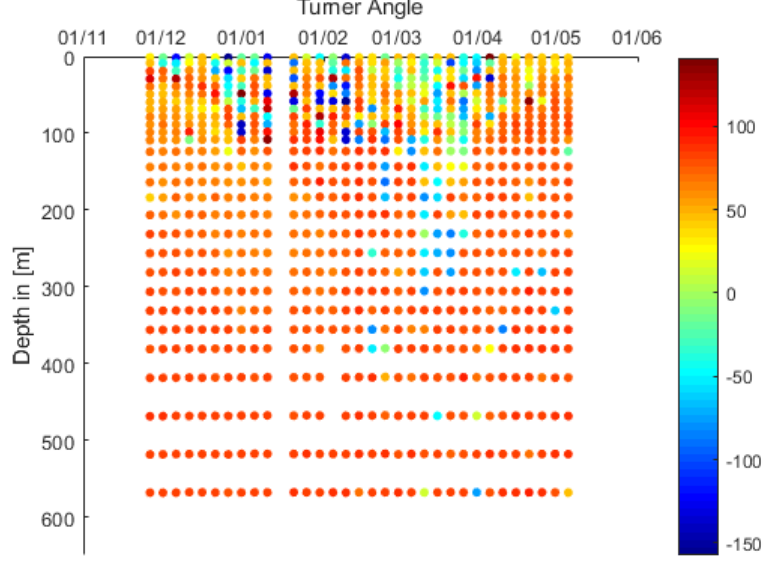
Figure 18. The Turner angle ( ◦ ) of float WMO 6900098 shows the contribution of salinity and temperature to density change.